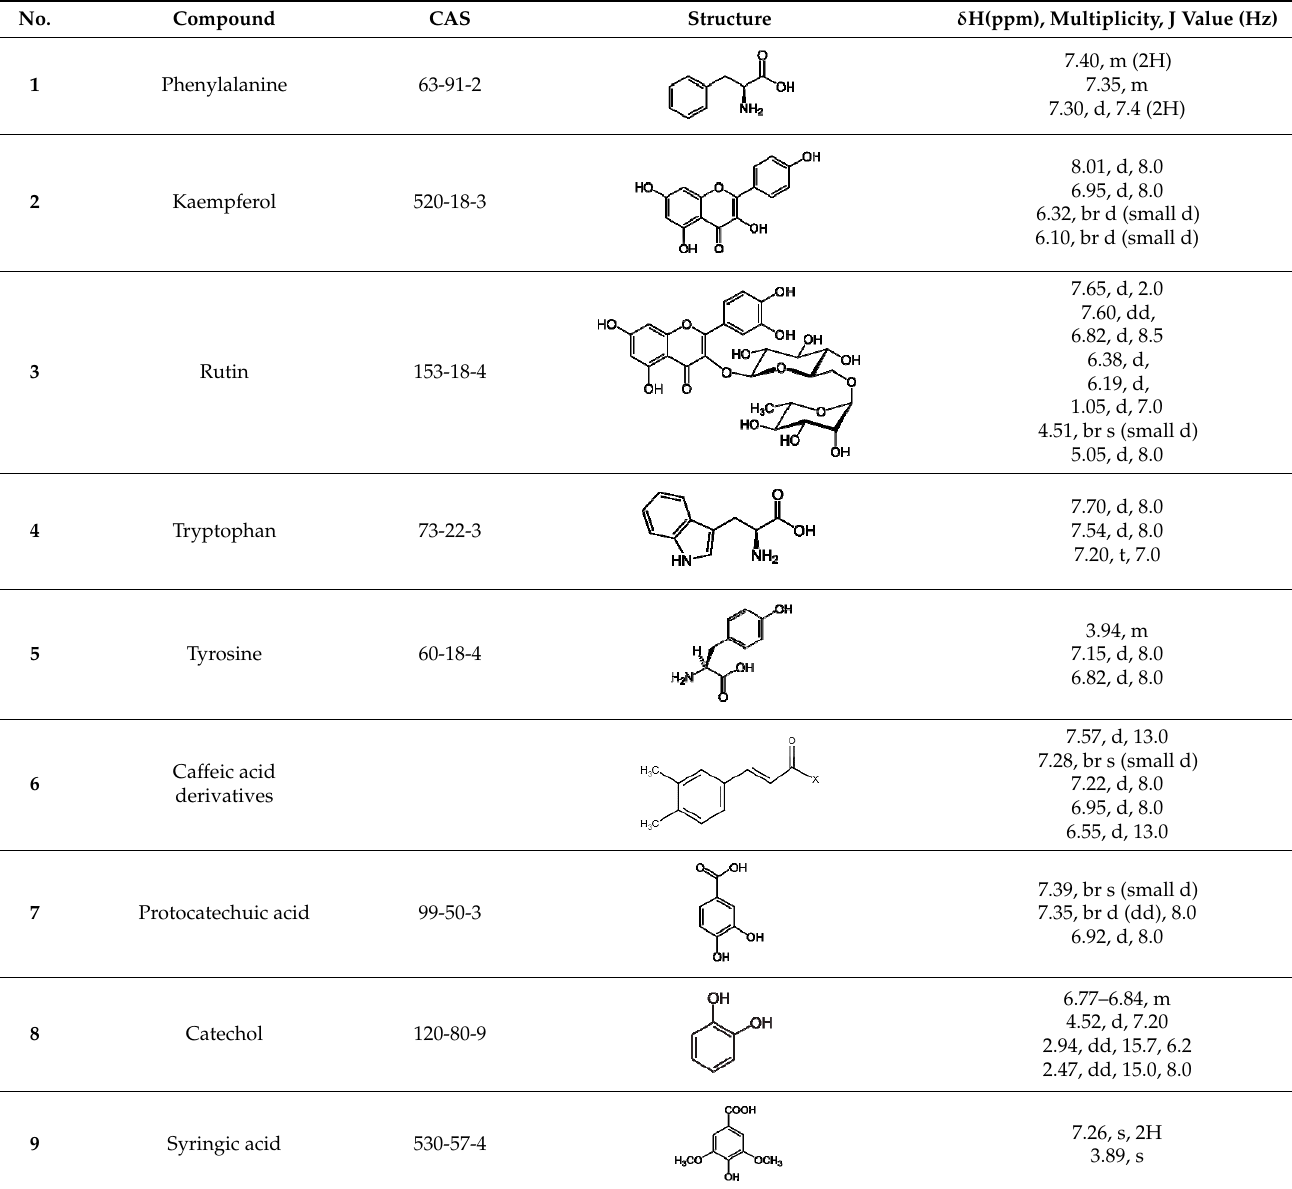
Table 1. The identified bioactive compounds and their characteristics.